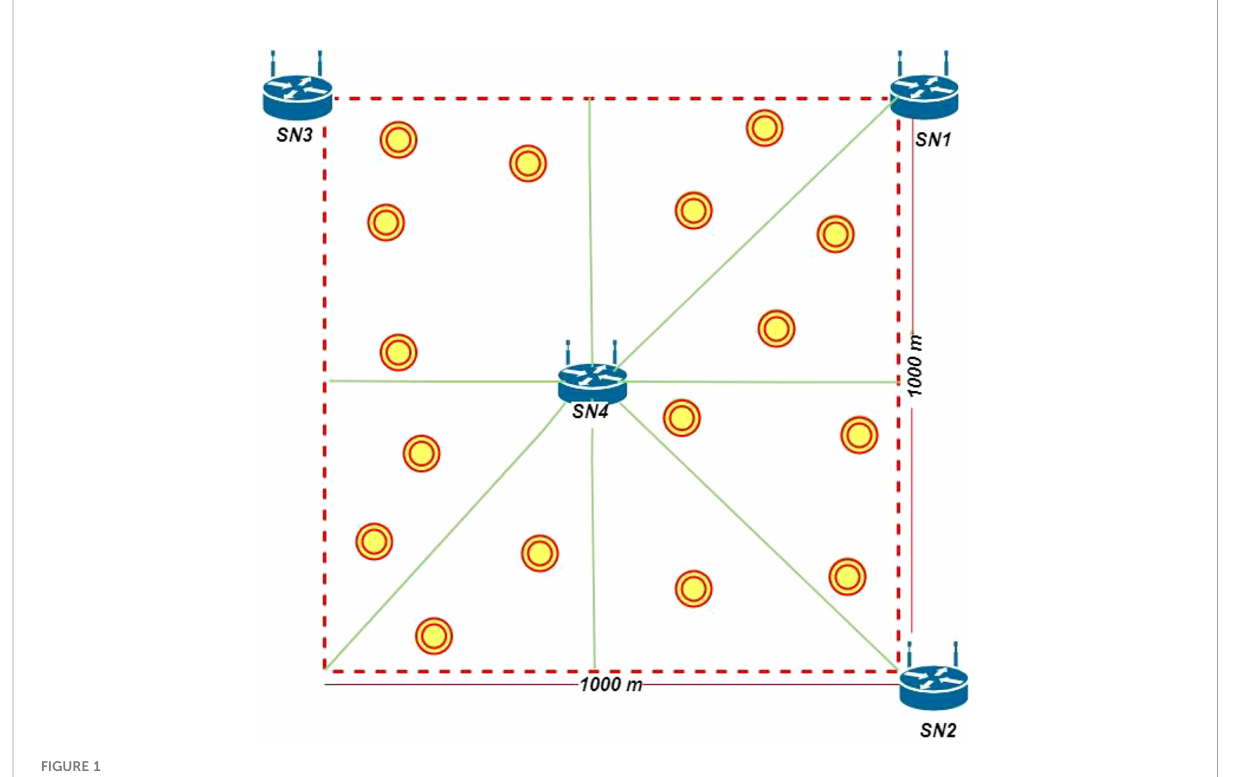
FIGURE 1 Proposed Network